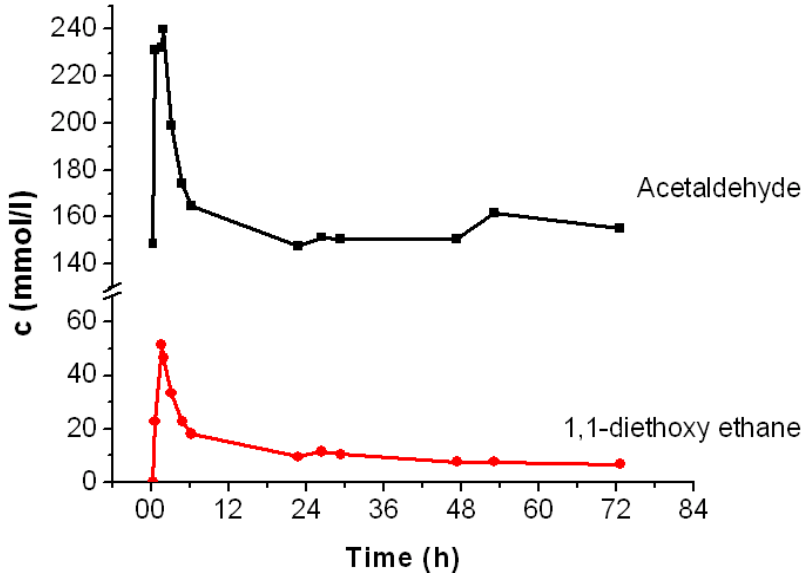
Figure 7. Acetaldehyde and 1,1-diethoxy ethane concentrations plotted as the function of